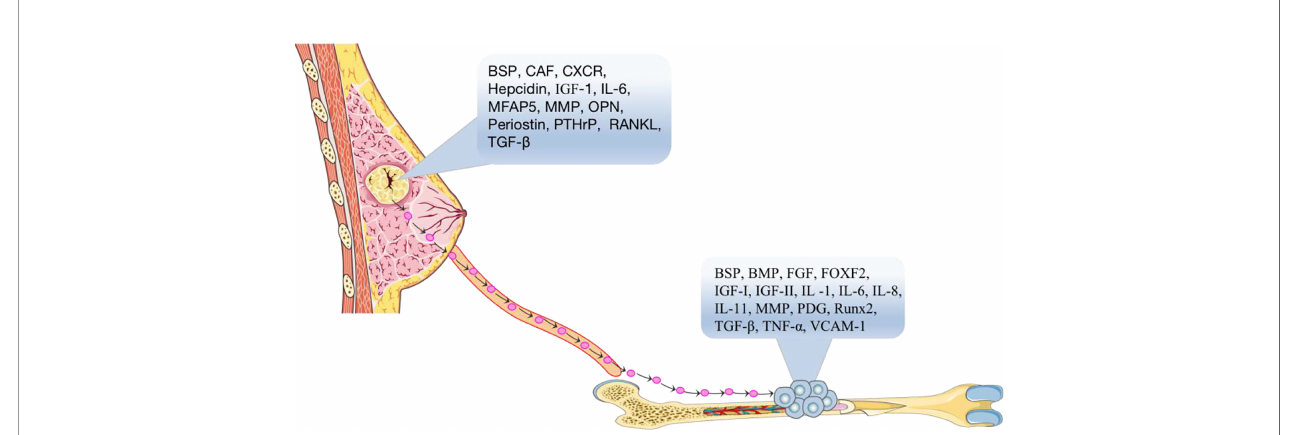
FIGURE 1 | According to the seed and soil hypothesis, the primary breast tumor is the “ seed ” in the blood that spreads to the suitable growth environment of bone tissue through the actions of cytokines, BSP, CAF, CXCR, hepcidin, IGF-1, IL-6, MMPs, OPN, Periostin, PTHrP, RANKL, TGF- b , etc. BSP, BMP, FGF, FOXF2, IGF-I, IGF-II, IL-1, IL-6, IL-8, IL-11, MMPs, PDG, RUNX2, TGF- b , TNF- a , VCAM-1 and other “ soil ” factors in the bone microenvironment, which are suitable for tumor cell growth and development, accelerate the process of bone metastasis of tumor